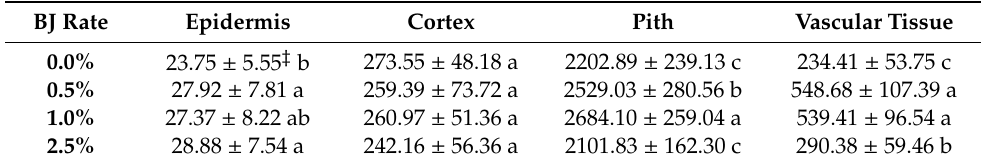
Table 2. Anatomical traits of basil stem tissue (epidermis, cortex, pith involved primary and secondary vascular tissues) ( µ m) after treatment with fermented BJ. Sample size n = 45 (Mean ±